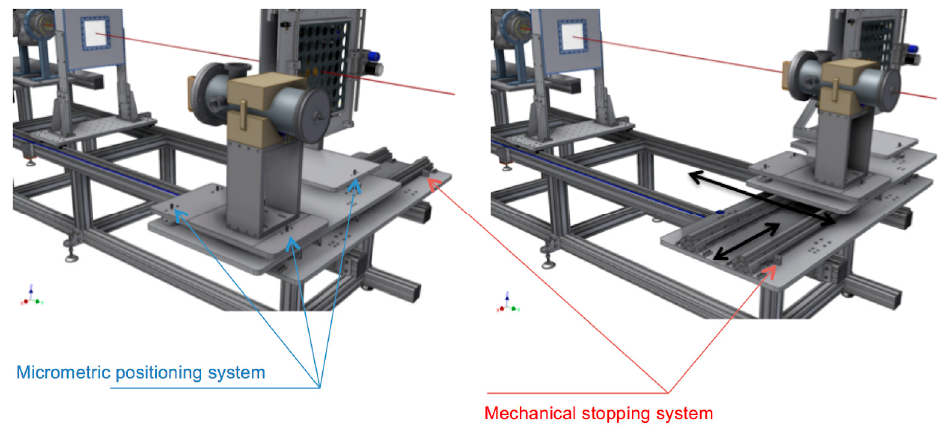
Figure 7. Diagram of the in-air final section of the ELIMAIA beam line, where the positioning system is visible. On the left and right are shown the different positions for respectively centering the FC and the SIS respect to the beam axis (in red).